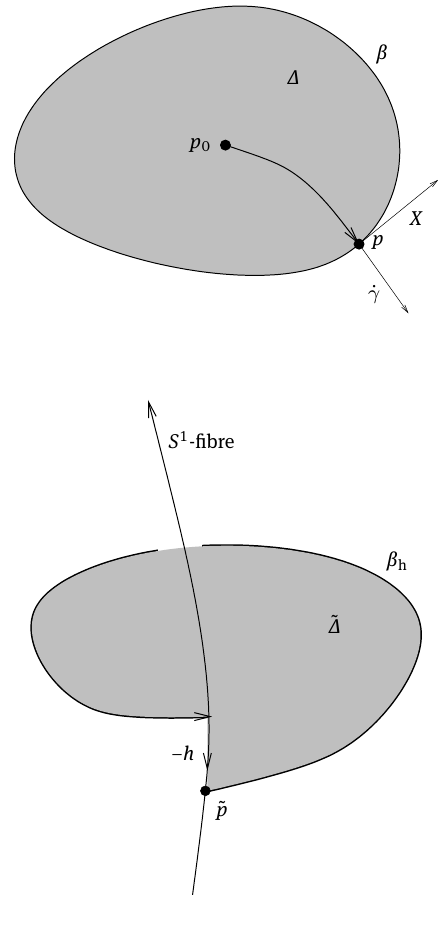
Figure 9: The lifted disc in M